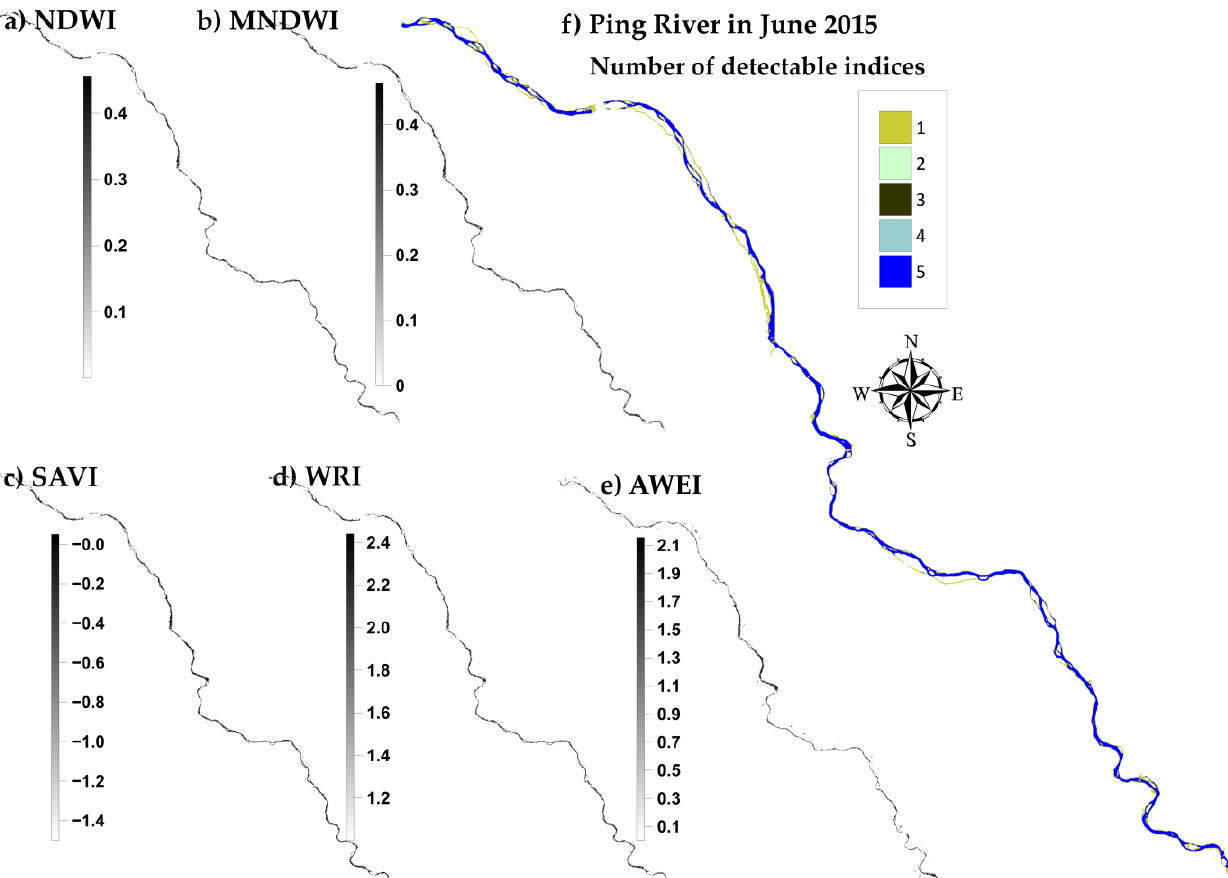
Figure 7. Stream extracted from Landsat-8 images in 2015 using ( a ) NDWI, ( b ) MNDWI, ( c ) SAVI, ( d ) WRI, ( e ) AWEI, and ( f ) river shape with a number of detectable water indices. Number 1 means only one index could detect. Numbers 2, 3, and 4 denote the areas that 2, 3, and 4 indices could detect, respectively. Number 5 represents the area that all water indices classify as Ping River.